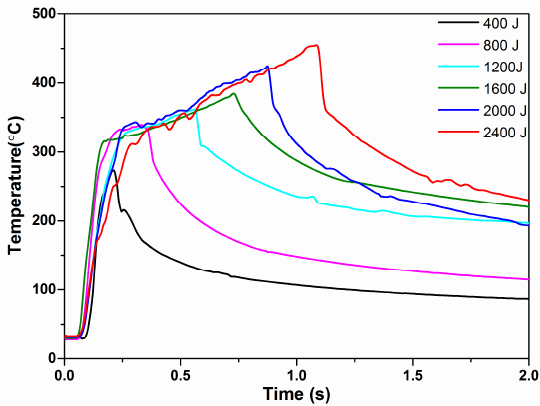
Figure 4. Temperature variation of weld interface recorded during USW for various welding energies.